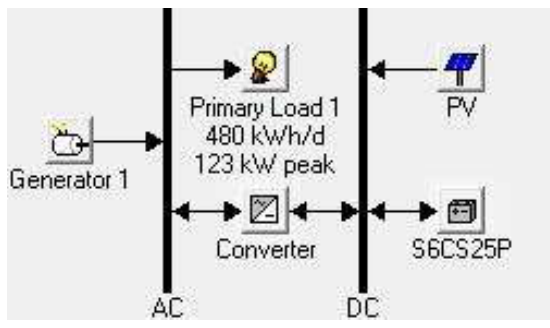
Figure 4. Off-grid Scenario: generating system. Table 3. Optimized on-grid hybrid energy-systems as the measure of the lowest NPC.